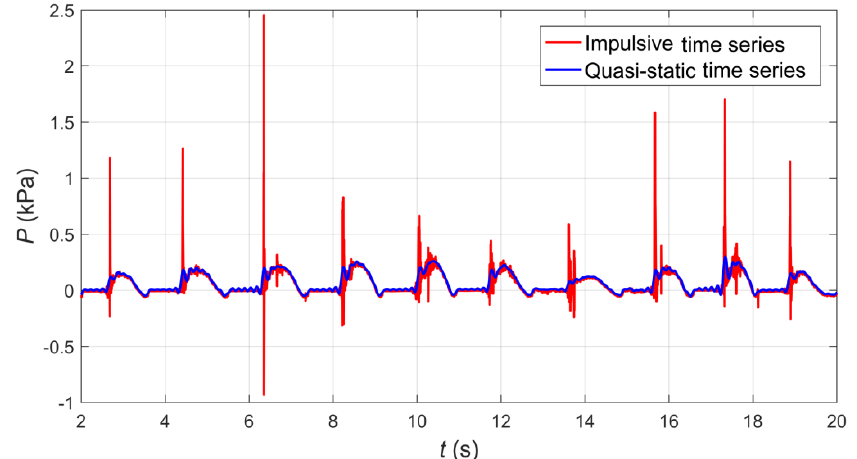
Figure 7. Comparisons between measured values P 1/3 of rebuilt pressure time series results and cal- culated values P qs+,cal from empirical formula for a cut-off frequency of 7 Hz.